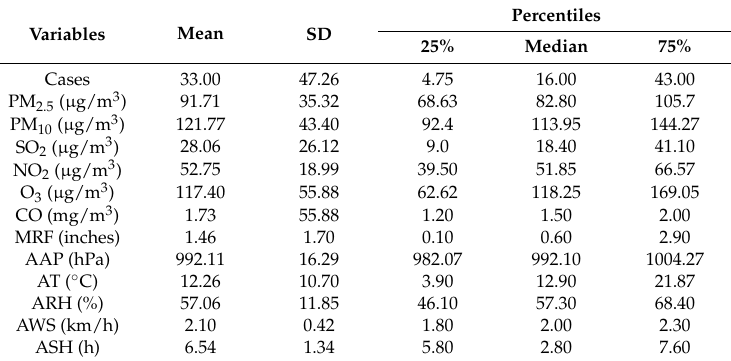
Table 1. Descriptive information of the outcome and predictor variables.